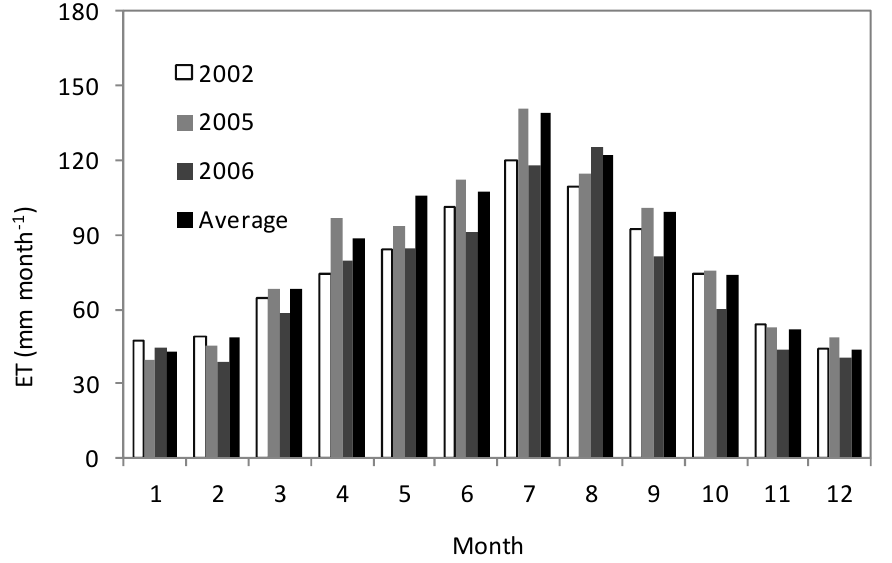
Figure 5. Seasonal variation in ET in the Poyang Lake wetland in 2002, 2005, and